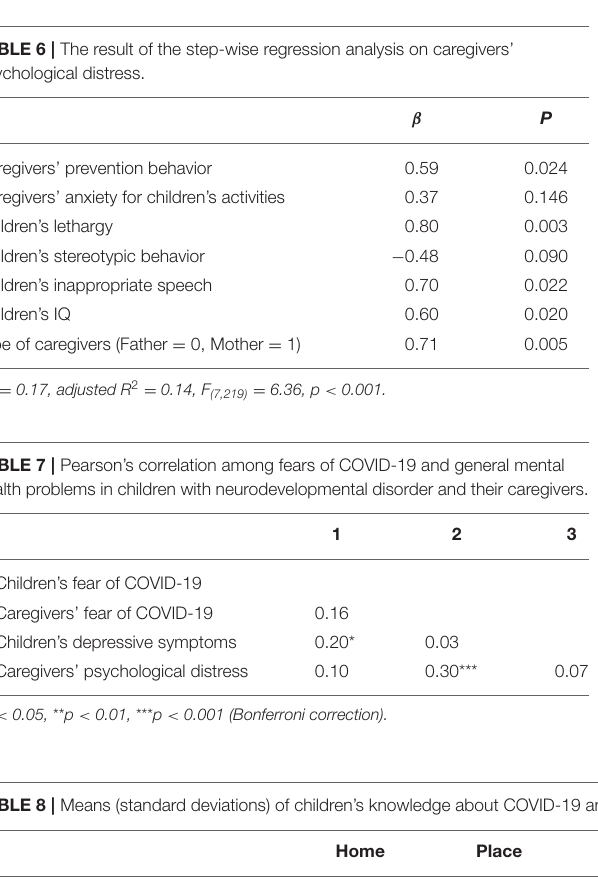
TABLE 6 | The result of the step-wise regression analysis on caregivers’ psychological distress.